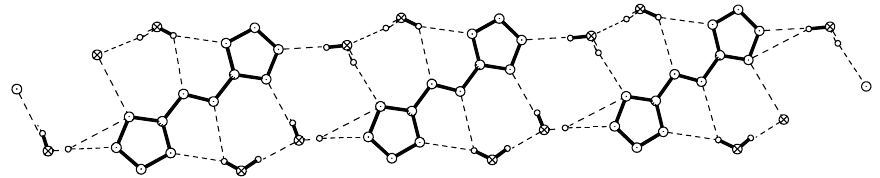
Figure 4. Ribbon motif formed through hydrogen bonding between the 5,5'-azotetrazolate dianions and the water of crystallization in the crystal structure of 1 .